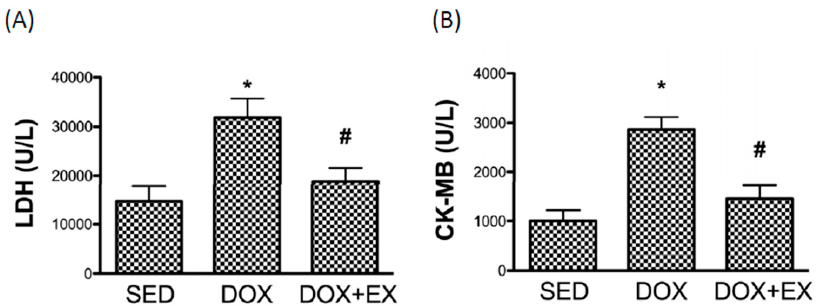
Figure 6. The effect of treadmill exercise on the concentration of two biomarkers of cardiac damage. The concentration of ( A ) lactate dehydrogenase (LDH) and ( B ) creatine kinase-MB (CK-MB) in SED, DOX, and DOX+EX groups in blood. * p < 0.05 compared to the SED group. # p <0.05 compared to DOX group .